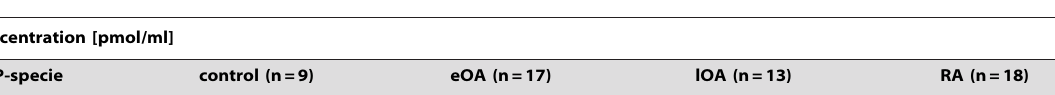
Table 2. Concentrations of bis(monoacylglycero)phosphate (BMP) species.